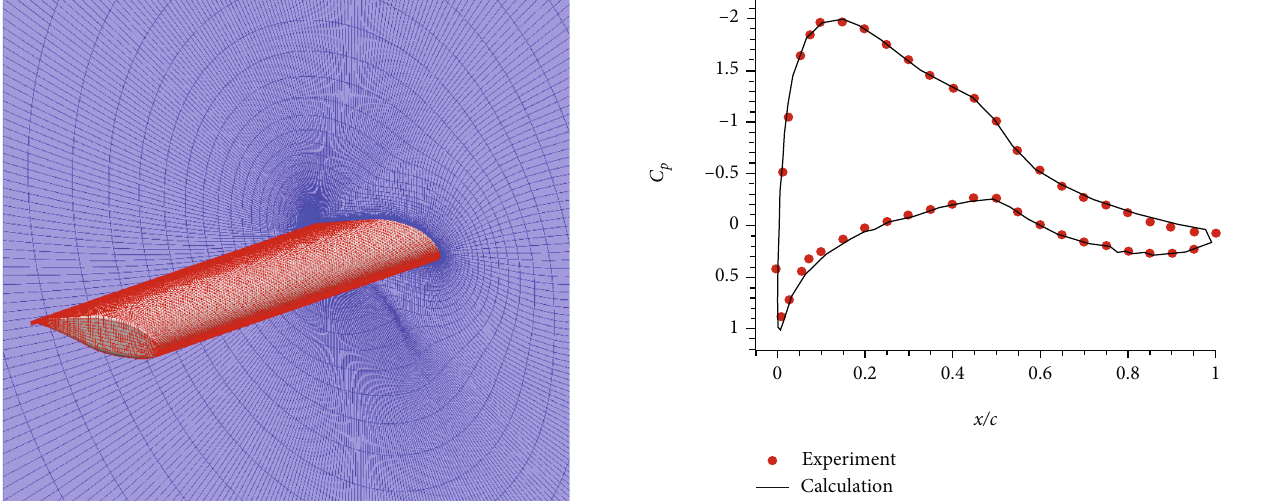
Figure 3: Wing and symmetry plane